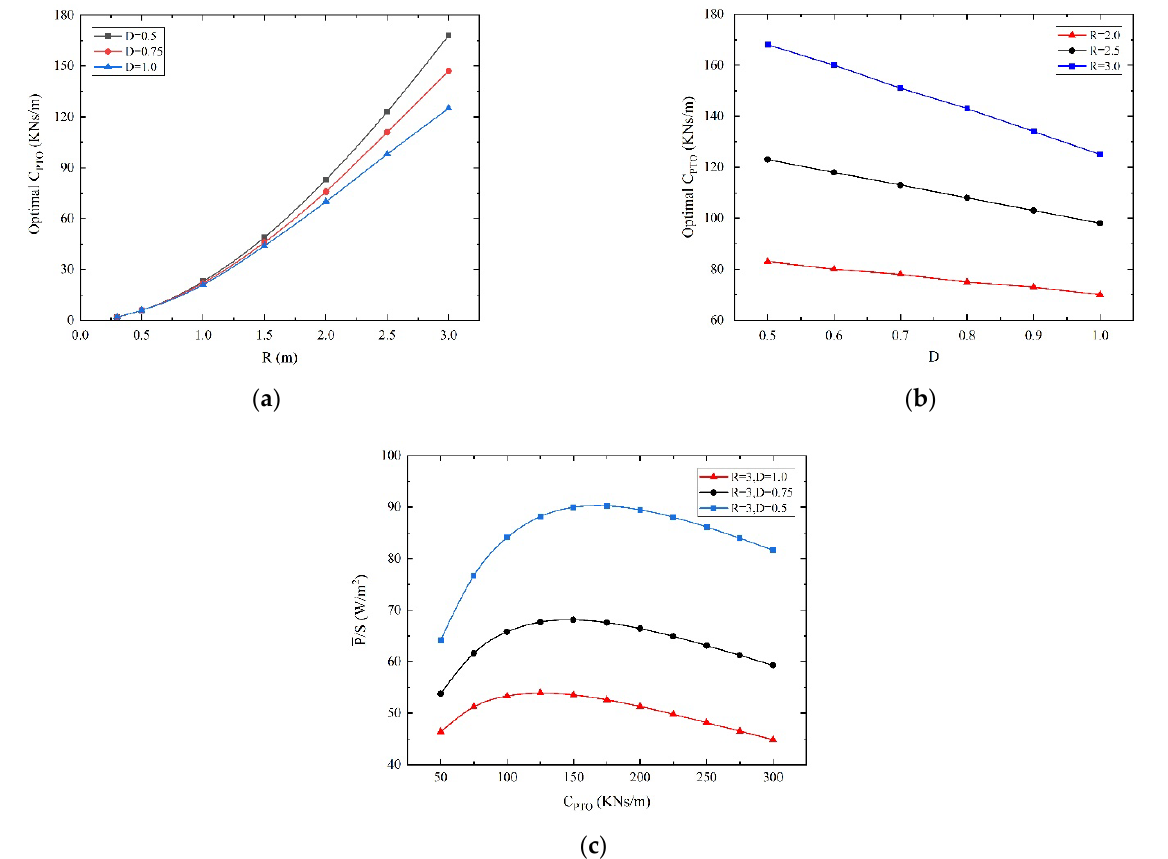
Figure 12. Optimal C PTO with buoy shape parameters. ( a ) Optimal C PTO with different R. ( b ) Optimal C PTO with different D. ( c ) P/S with different C PTO.